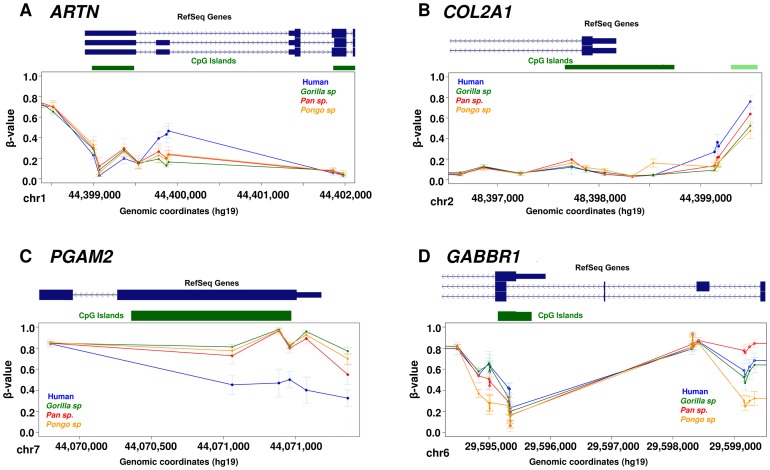
Examples of differentially methylated genes.Each data point represents the mean β-value of the group and whiskers show 2 standard deviations above and below the mean. (A) ARTN is a neurotrophic factor and it shows hypermethylation of 3 CpG sites associated with the long isoform specifically in human. (B) COL2A1 shows hypermethylation of 4 CpG sites at the promoter specifically in human. This gene encodes the alpha-1 chain of type II collagen, which is found primarily in cartilage, the inner ear and the vitreous humor of the eye. (C) PGAM2 shows hypomethylation of CpG sites at the promoter specifically in human. PGAM2 is an enzyme involved in the glycolitic pathway, mutations in which are associated with muscle cramping and intolerance for strenuous exercise. (D) GABBR1 shows a complex methylation pattern in which human and gorilla shows similar pattern of methylation, orangutan shows relative hypomethylation, while chimpanzees and bonobos show increased methylation levels at TSS and intermediate levels associated with the short isoform of this gene. GABBR1 is a neuronal receptor involved in synaptic inhibition, slow wave sleep, muscle relaxation and sensitivity to pain.